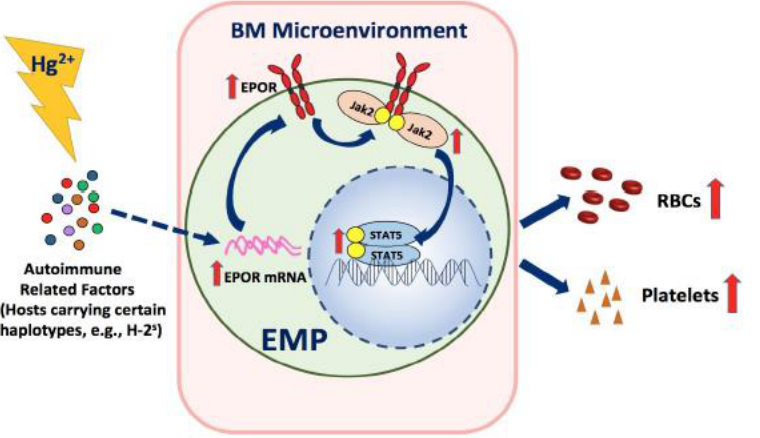
Figure 8. A schematic model for the impact of Hg 2+ on erythro-megakaryopoiesis in mice. In hosts carrying certain H-2 haplotypes sensitive to Hg-induced autoimmunity (e.g., B10.S mice, H-2 s ), Hg 2+ induces an autoimmune environment, which leads to the increased expression of EPOR in EMPs and signaling pathway is overactivated by EPO interaction with EPOR in EMPs, thus resulting in the in-